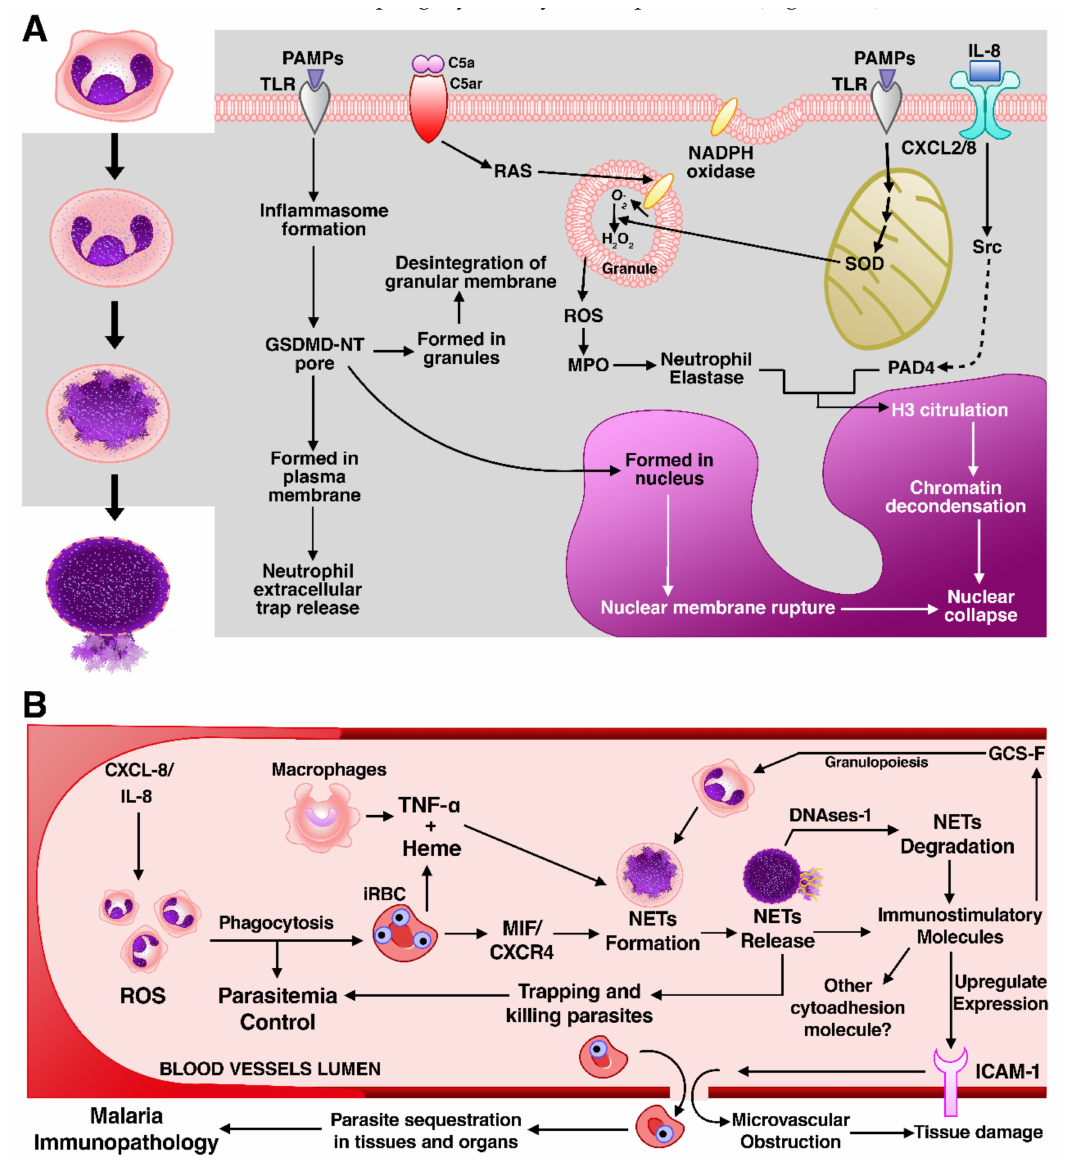
Figure 5. NETosis is a cause of intravascular inflammation in malaria. ( A ) A simple overview of NETosis. On the left side of the figure (white background), neutrophils’ morphological alterations during NETosis include chromatin swelling, which causes disintegration of nuclear and plasma membrane and the release of extracellular traps. On the right, the molecular mechanisms of NETosis. ( B ) After Plasmodium infection, neutrophils are rapidly recruited by IL-8/CXCL-8 to perform their functions, which comprise NETs formation to trap and kill parasites, but the cleavage of NETs by DNase1 facilitates NETs immunostimulatory molecules’ dissemination, causing the increase in neutrophils granulopoiesis and the upregulation of intercellular adhesion molecule-1 (ICAM-1), which promotes iRBC sequestration and inflammatory vasculature. All of these processes are considered key contributors to malaria immunopathology. C5a: Complement component 5a;